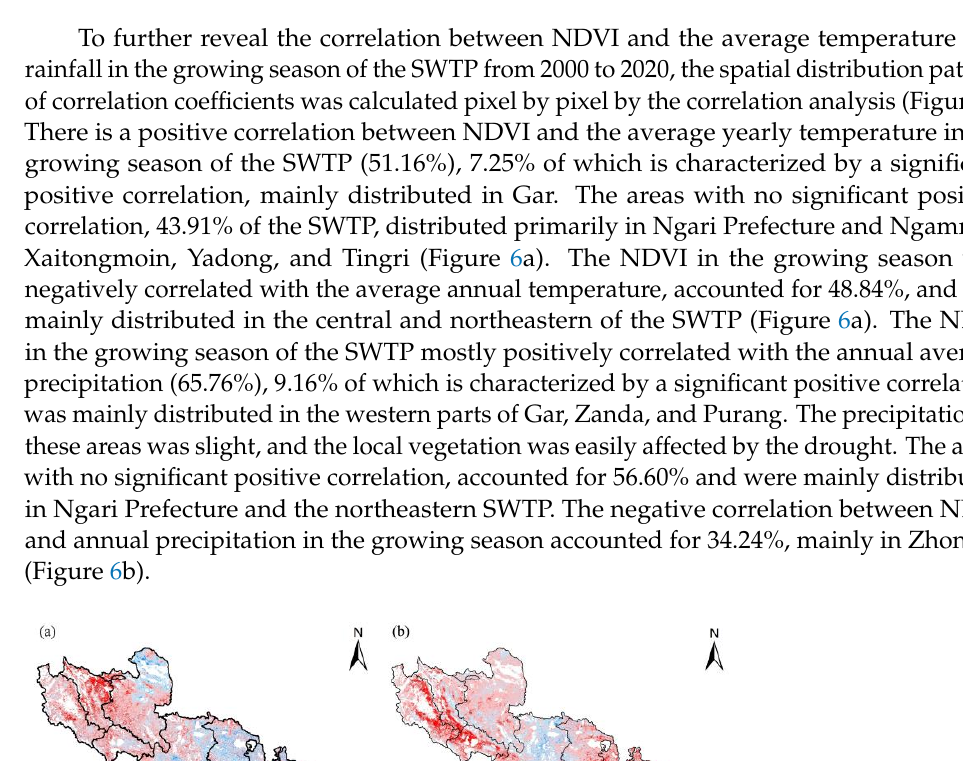
Figure 5. Interannual variation and correlation of NDVI with mean temperature ( a ) and precipitation ( b ) in the SWTP from 2000 to 2020.